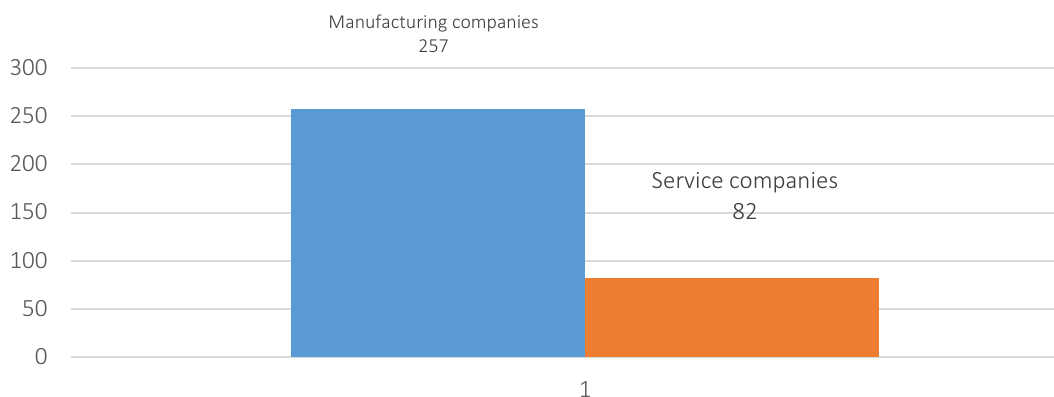
Companies without foreign currency loans; 160